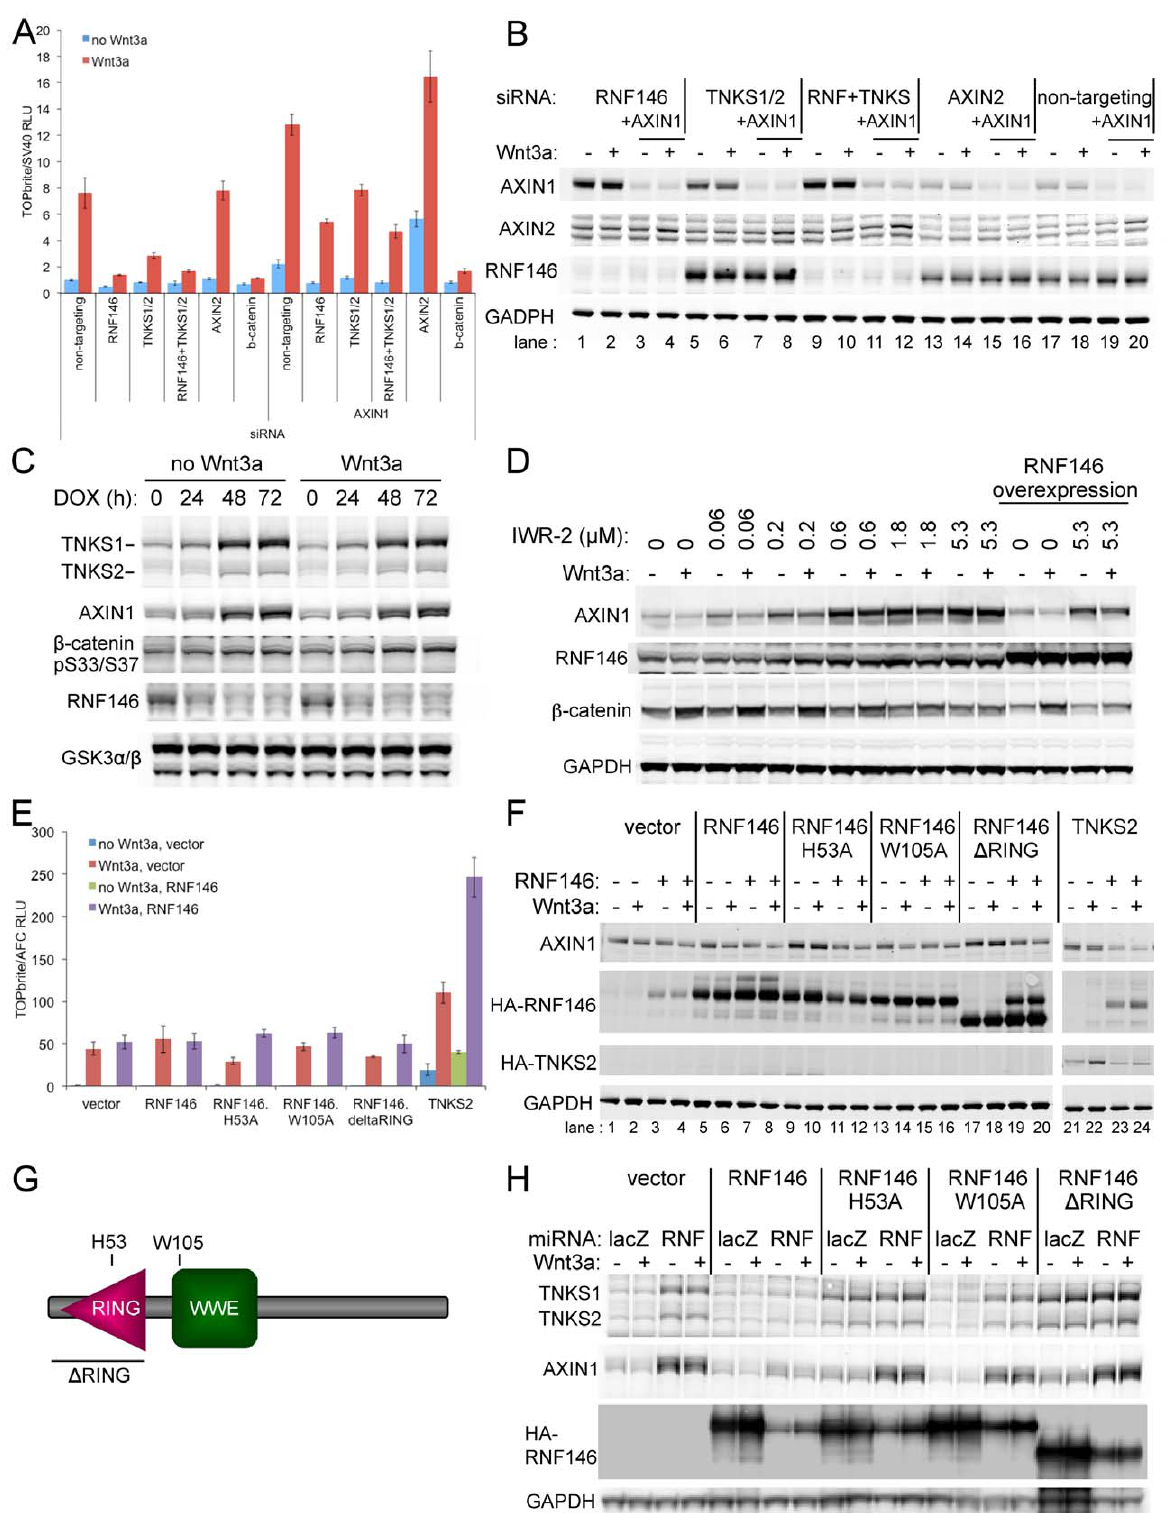
Figure 3. RNF146 and tankyrase function coordinately in Wnt signaling and regulate each other’s protein stability. (A) Effects on Wnt signaling in the HEK293 reporter stable cell line with and without Wnt3a stimulation for siRNAs targeting RNF146, the combination of tankyrases TNKS1 and TNKS2, or the combination of all three genes. On the right half of the graph, these siRNAs are also combined with AXIN1 siRNA. AXIN2, b - catenin, and non-targeting siRNAs serve as controls. (B) Western analysis of whole cell lysates for HEK293 cells treated as in (A). (C) Time course of tankyrase (TNKS1 and TNKS2) and Axin stabilization in HEK293T cells stably expressing RNF146 miRNA that was induced for the indicated times with doxycycline (DOX), with or without Wnt3a added for the final 12 h of DOX induction. b -catenin phosphorylation and RNF146 protein knockdown